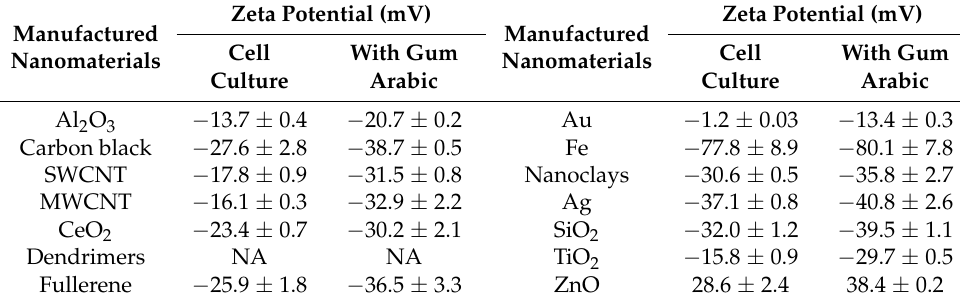
Table 4. Zeta potential of manufactured